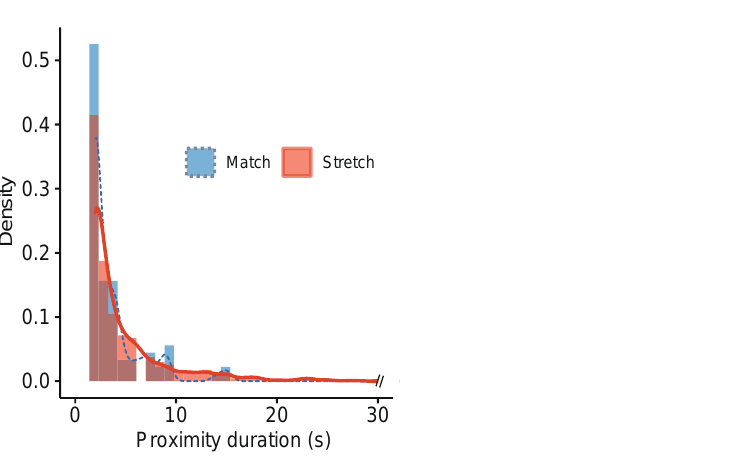
Figure 5. Density plot of the duration for each proximity ID during match time and stretching time.